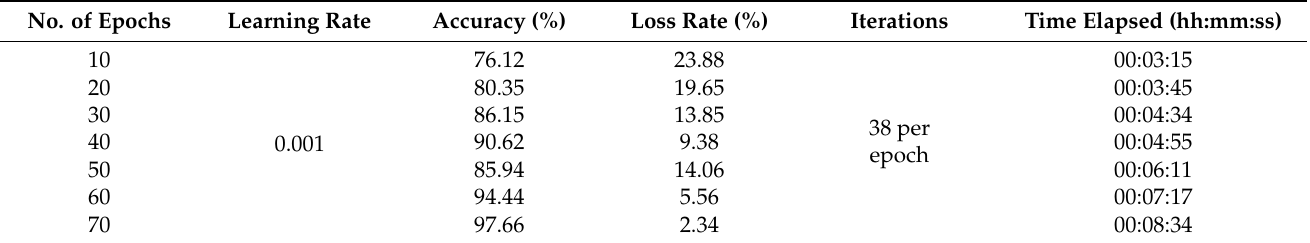
Table 5. Proposed model training simulation accuracies.